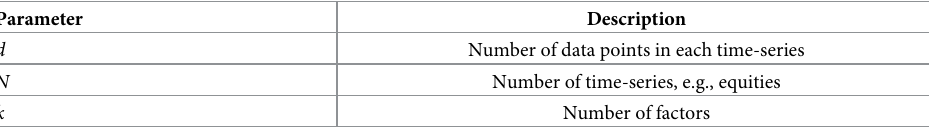
Table 1. The central parameters